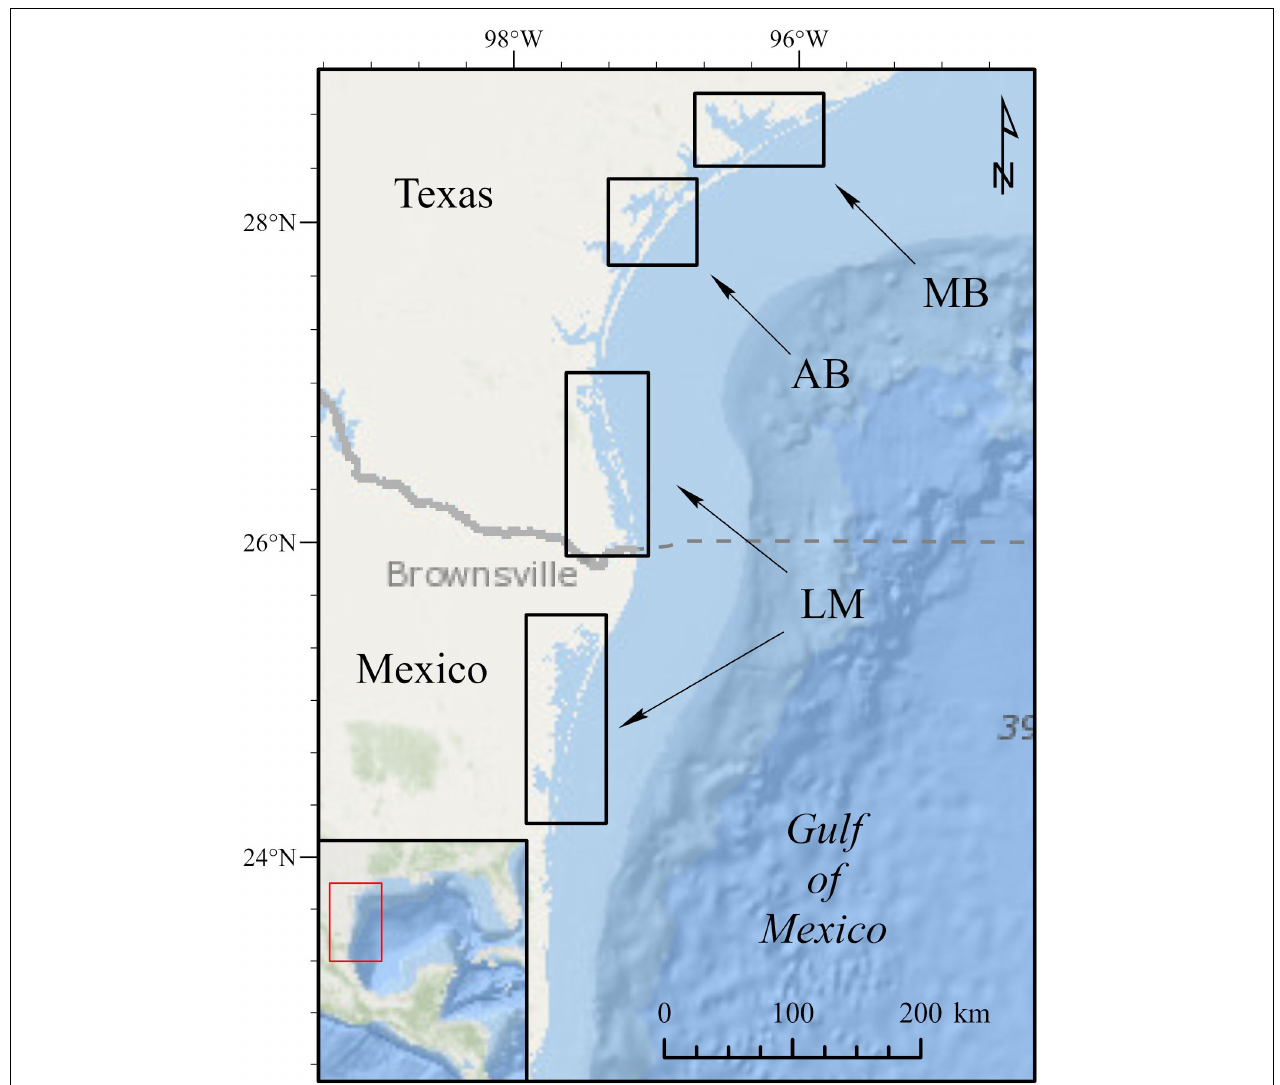
FIGURE 1 | Northwestern Gulf of Mexico showing location of major bay systems where juvenile green turtles were collected and tracked from 2006 to 2011. These bays include: Matagorda Bay (MB), the Aransas Bay complex (AB), and the Laguna Madre (LM). The Laguna Madre in Mexico represents overwintering areas utilized by juvenile green turtles; no turtles were collected from this bay system. The dashed gray line represents the limit between the Exclusive Economic Zones of the United States and